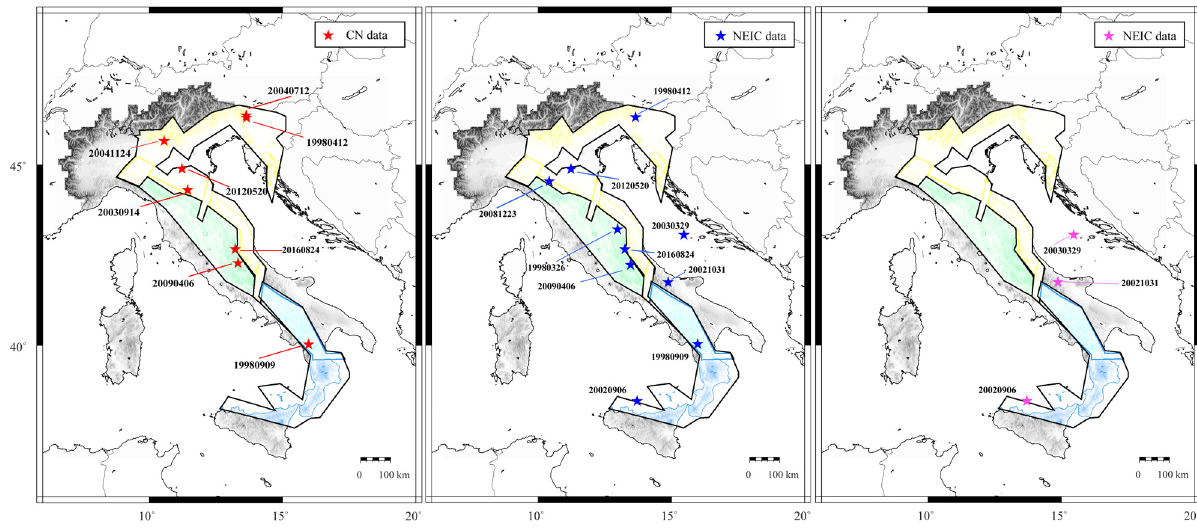
Figure 2. (a) Location map of earthquakes (red stars) listed in Table 1. (b) Location map of earthquakes (blue stars) listed in Table 2. (c) Lo- cation map of earthquakes (magenta stars) listed in Table 2 that did not occur inside the macro-zones considered by the CN